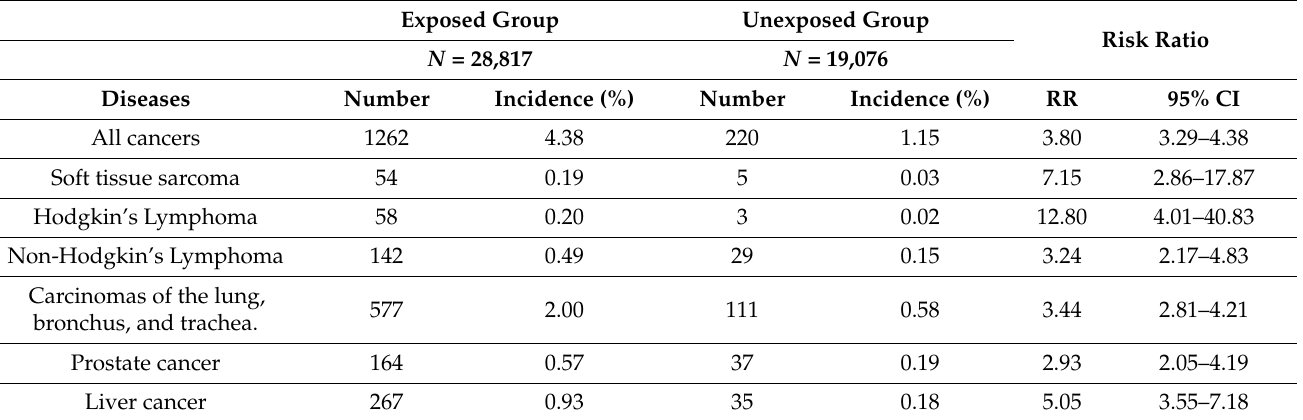
Table 3. Risk ratio (RR) of cancer among Vietnamese veterans exposed to dioxins in the years